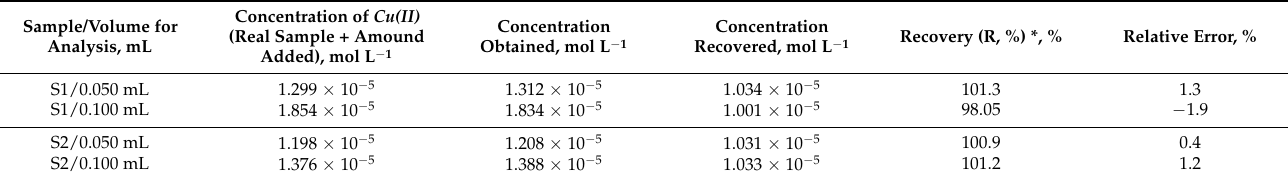
Table 3. Percentage recovery of Cu(II) in spiked sample, using spiking levels of 1.021 × 10 − 5 mol L − 1 (S1 sample: 2.776 × 10 − 6 (in 0.050 mL) and 8.329 × 10 − 6 (in 0.100 mL) mol L − 1 ; S2 sample: 1.775 × 10 − 6 (in 0.050 mL) and 3.550 × 10 − 6 (in 0.100 mL) mol L − 1.